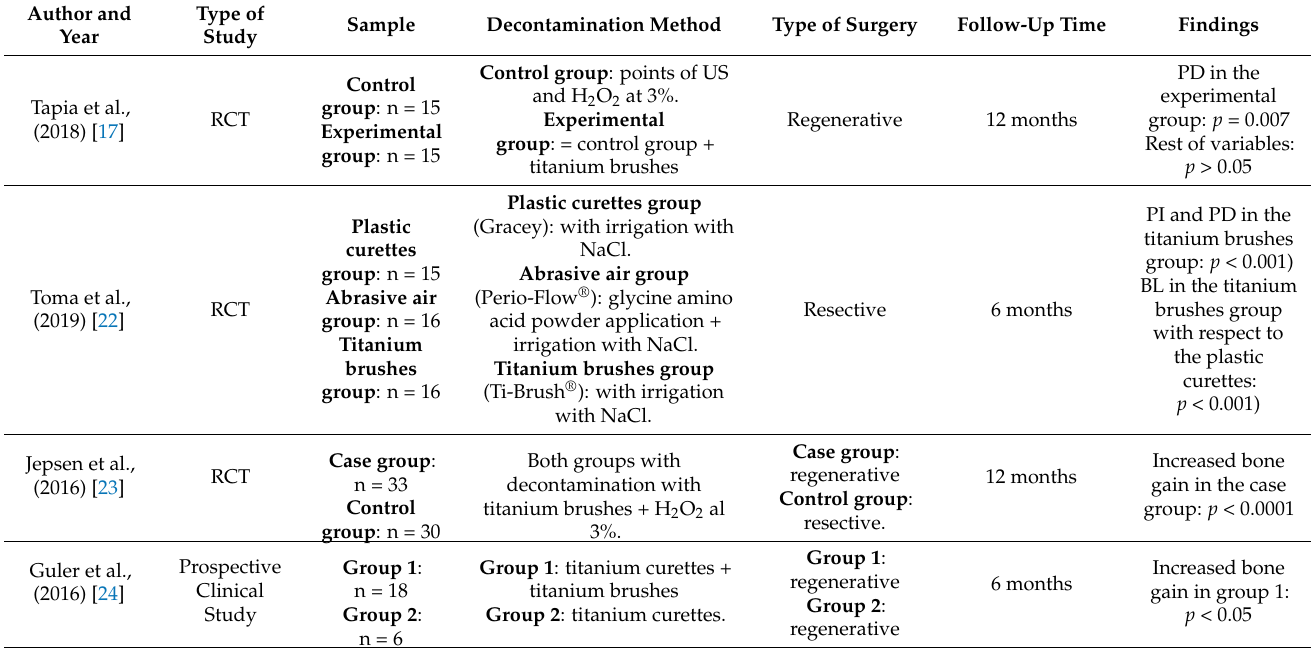
Table 2. Synthesis of the methodology and results of the studies included in the review.